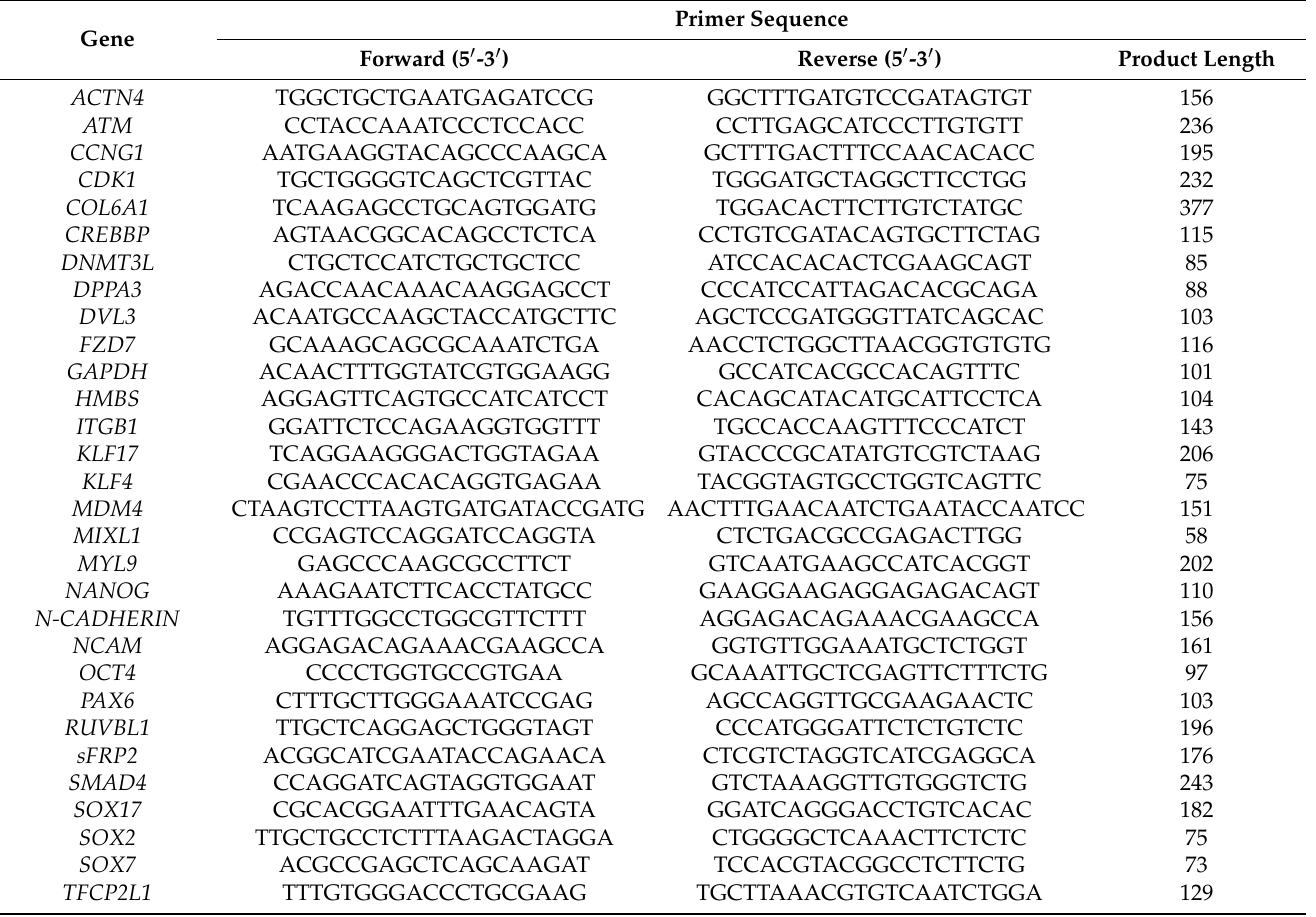
Table 1. List of human primer sequences used in